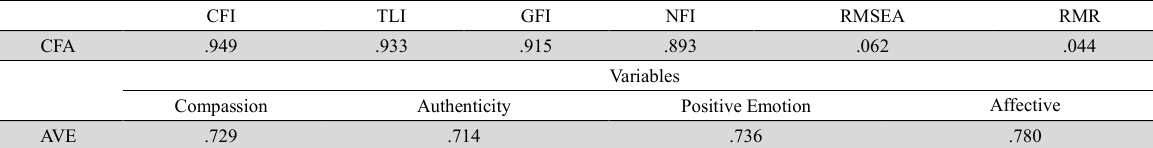
Confirmatory Factor Analysis Results